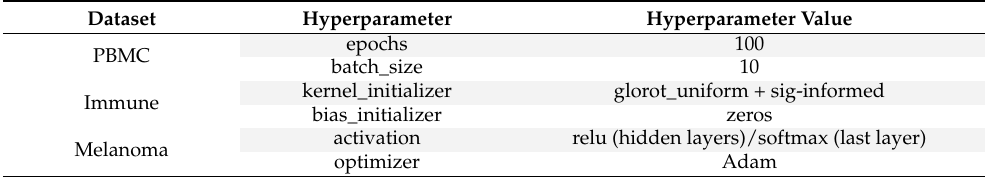
Table 2. Hyperparameter